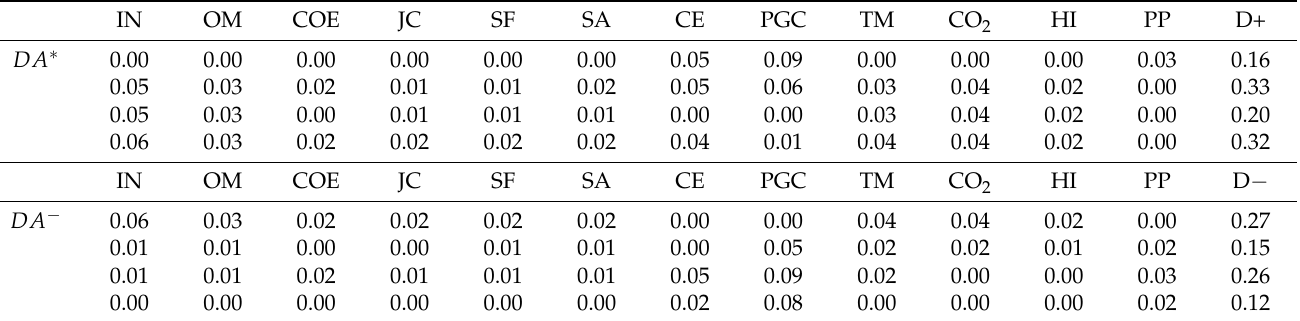
Table 10. Distances between the WtE alternatives and A ∗ , A − with regard to each criterion.